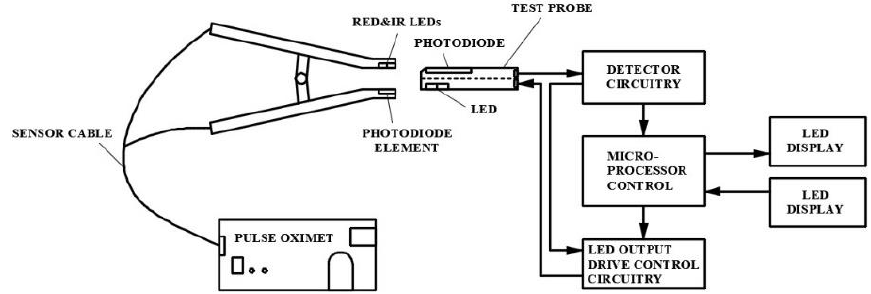
Figure 4. Schematic diagram of the LED emitter and photodiode calibrated by the pulse oximeter simulator.